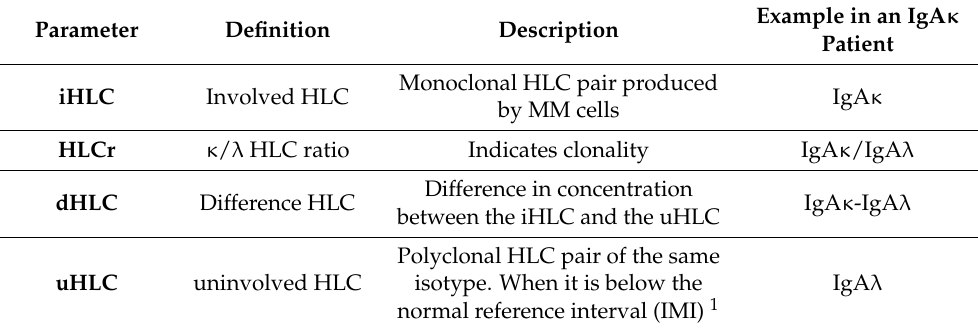
Table 2. Description of the heavy/light chain (HLC) assay